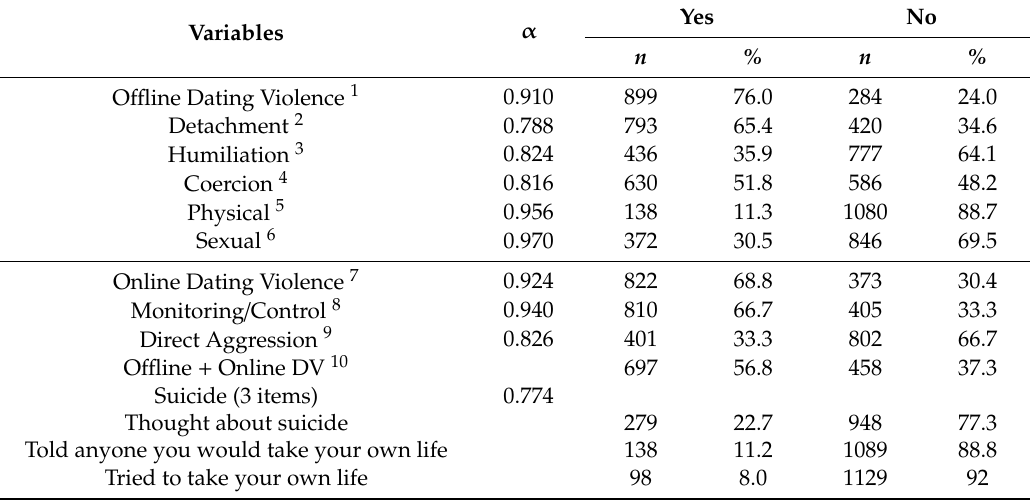
Table 1. Prevalence Dating Violence and Suicide